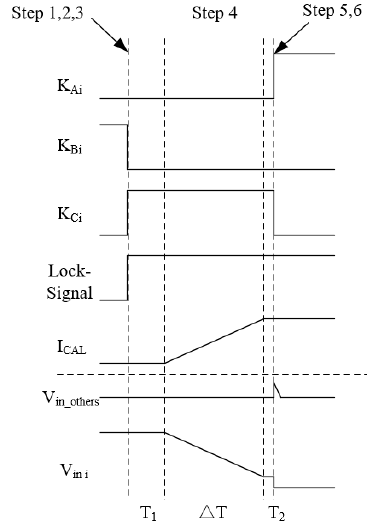
Figure 8. The sequence diagram of ASB.